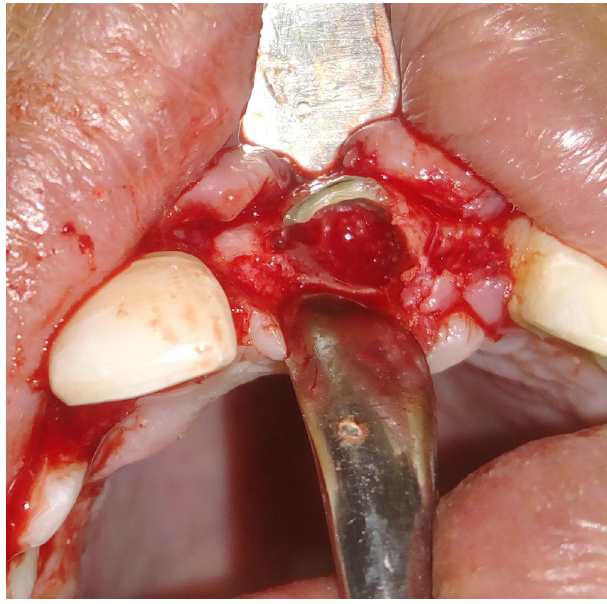
Fig. 2. Prepared socket shield.